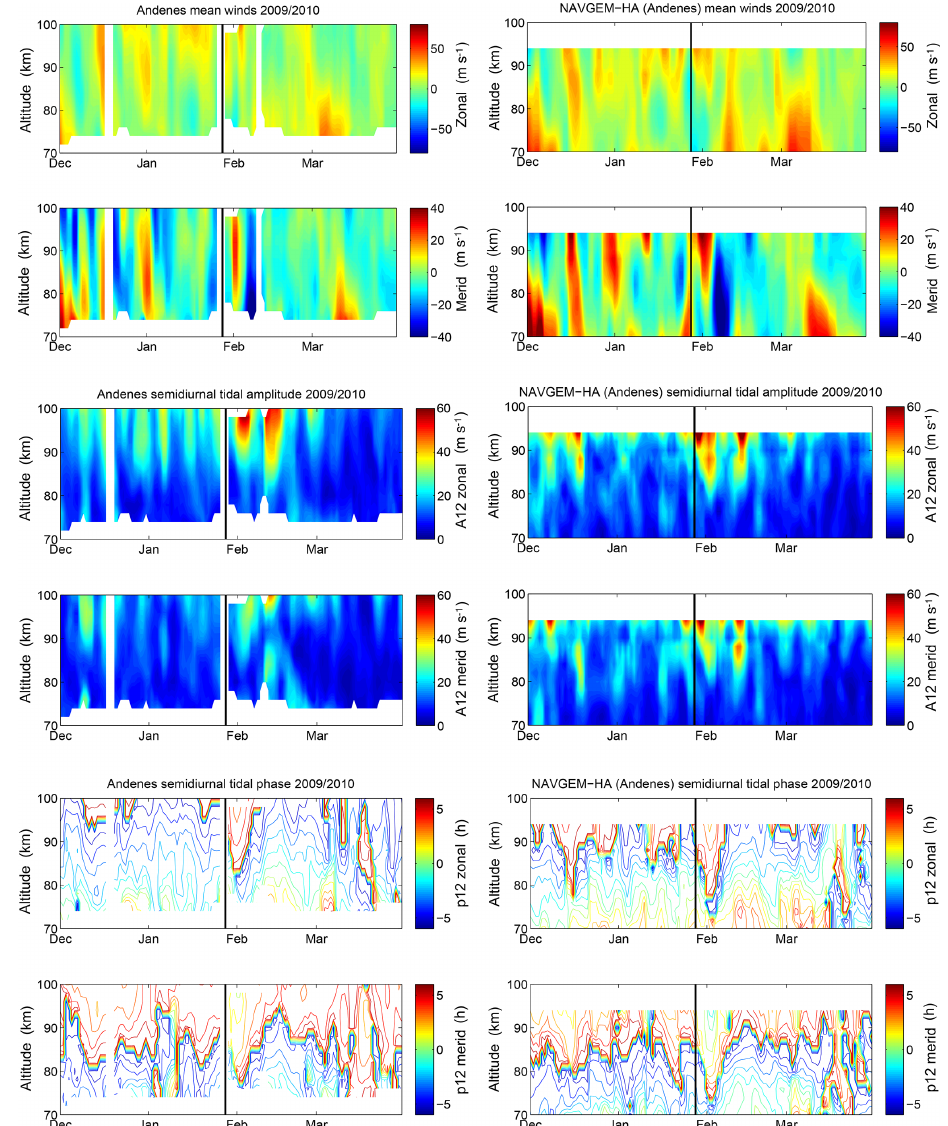
Figure 6. Comparison of meteor radar observations and NAVGEM-HA above Andenes during the winter of 2009/10 for daily mean zonal and meridional winds (two upper panels), semidiurnal tidal zonal and meridional amplitude (middle panels) and semidiurnal tidal phases (two lower panels). The labels A12 and p12 correspond to the semidiurnal amplitude and phase using the local